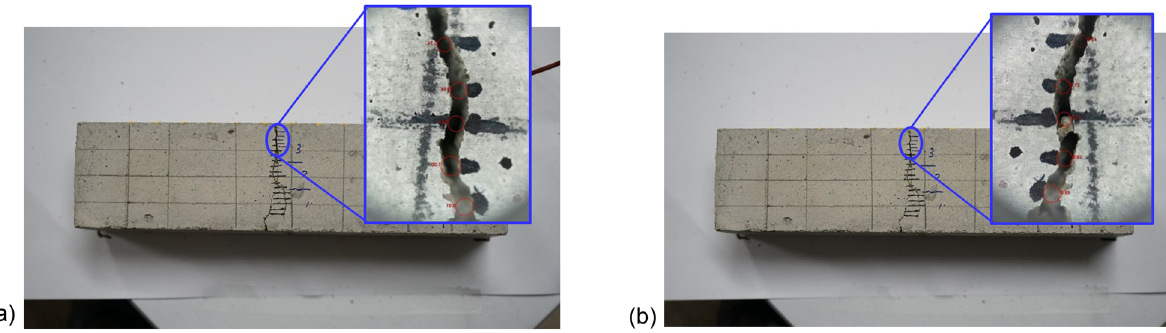
Figure 10: Examples of crack width measurements on the SMAF - 075 specimen: ( a ) before and ( b ) after the activation of the SME in the SMA fi